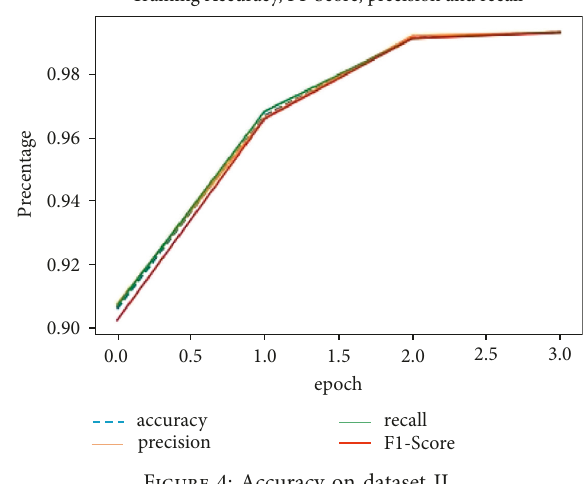
Table 6: Effect of dropout value.